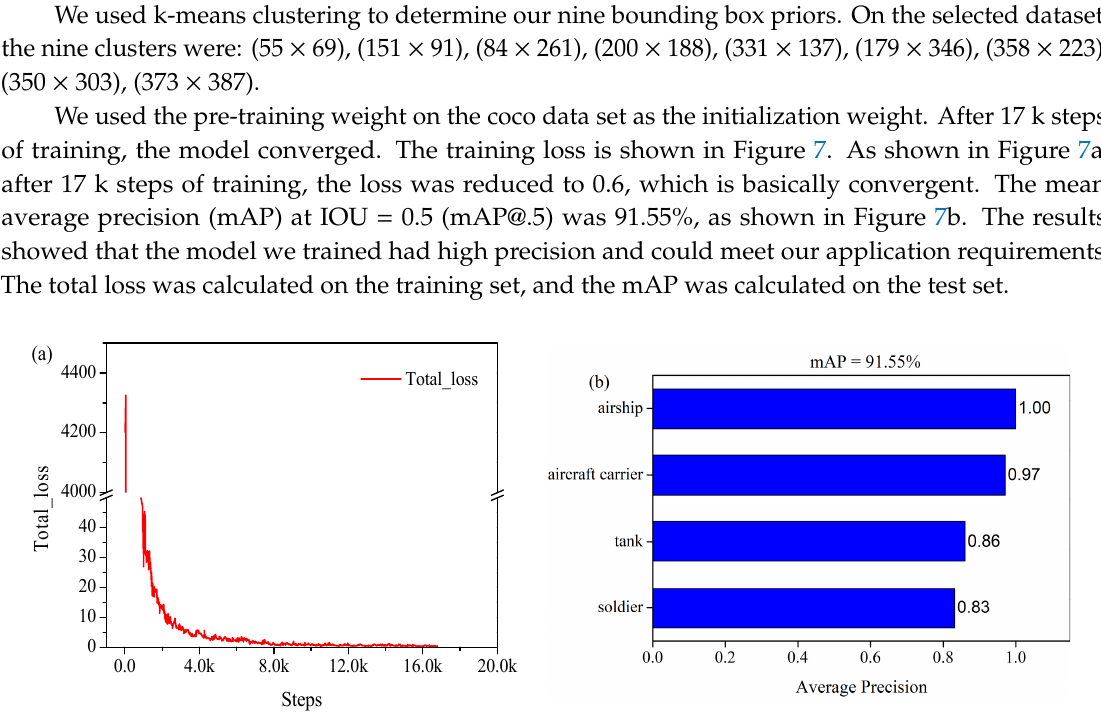
Figure 7. The total training loss and mean average precision. ( a ) the total loss; ( b ) the mAP.